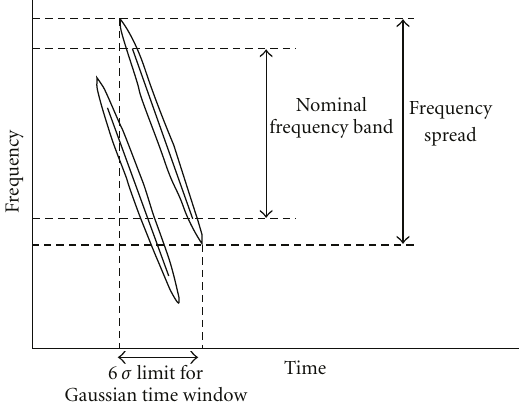
Figure 3: Schematic of the time-frequency structure of the DC series double chirp pulses.